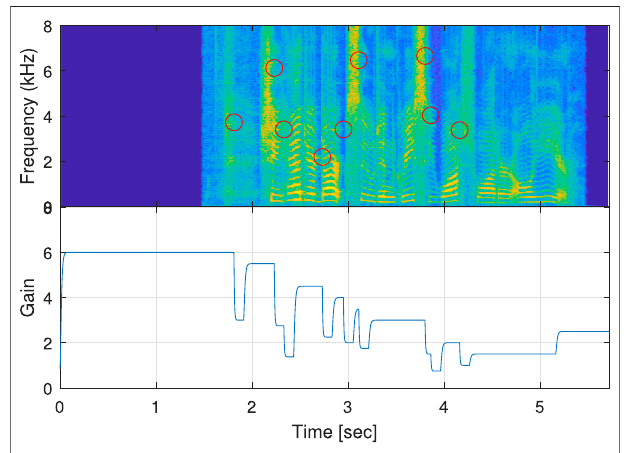
FIGURE 9 | Comparison of the spectrogram of the system ’ s loudspeaker signal, and the applied ampli fi cation-gain (Gain) over time, under the scenario of K = 6 and clean-signal, where mic2 ’ s location is [ 0 . 375 , 2 . 5 ] (single-microphone solution).